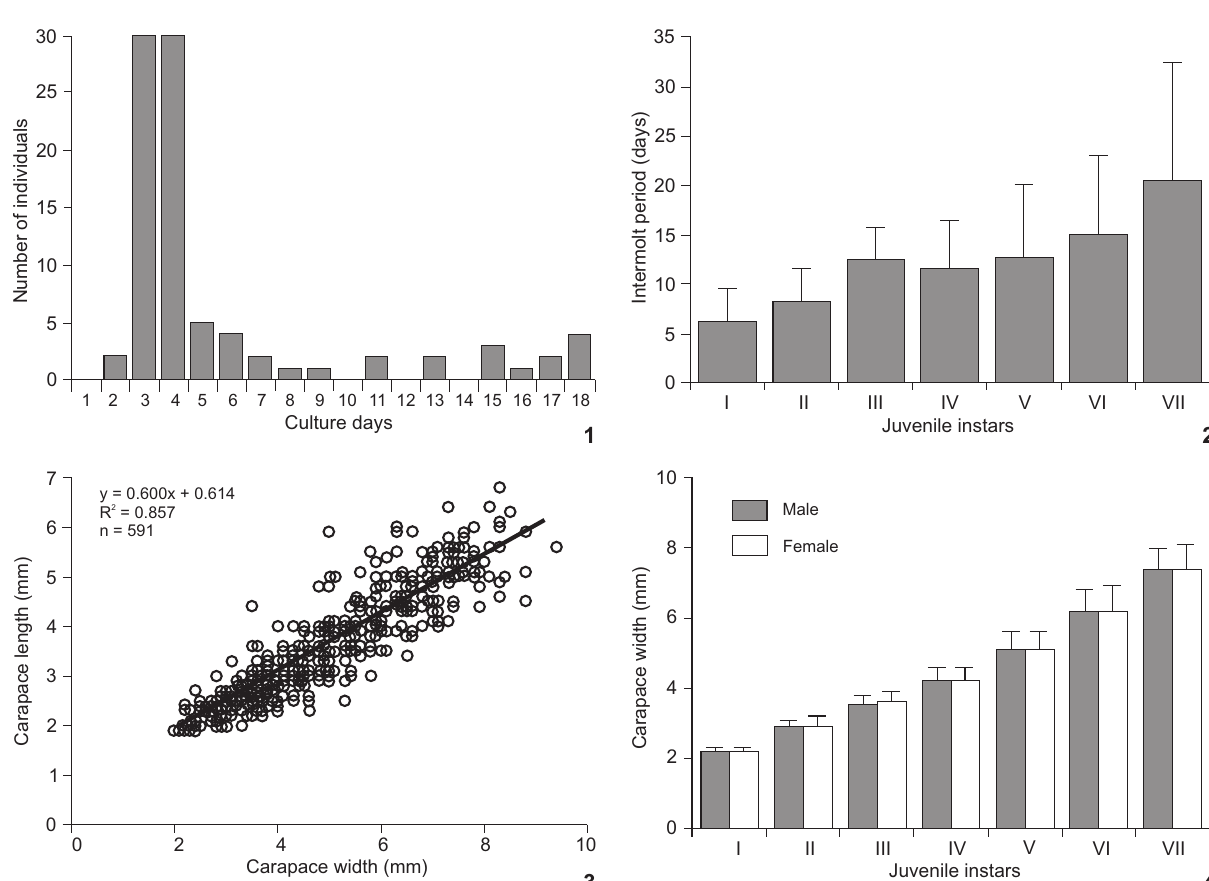
Figures 1-4. Pachygrapsus gracilis : (1) intermolt period of the megalopa stage; (2) mean of intermolt period (days) of each juvenile instar; (3) carapace width and carapace length at each juvenile instar; (4) mean carapace width of males and females at each juvenile instar.